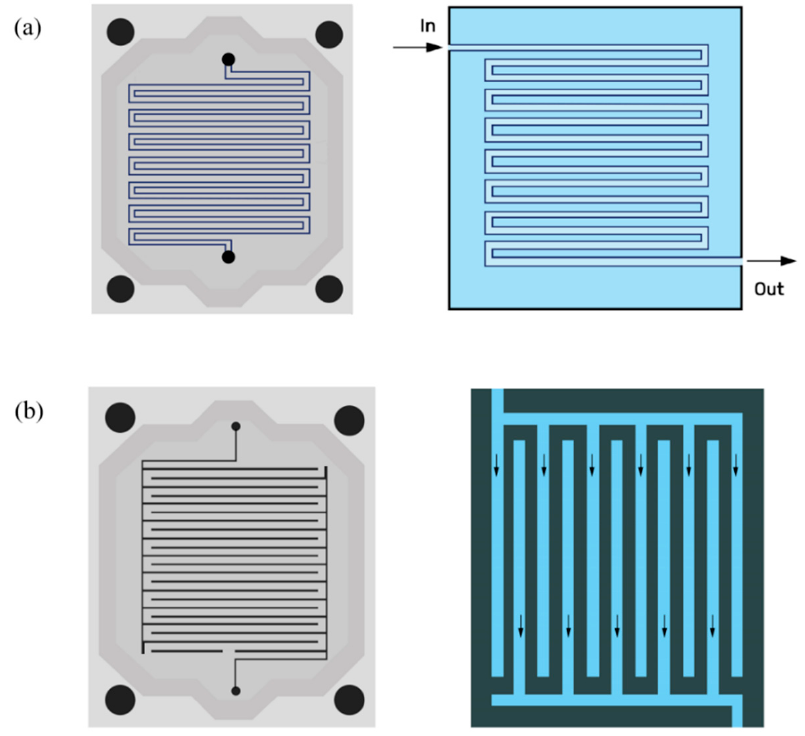
Figure 7. Flow channel designs: ( a ) Serpentine flow field; ( b ) Interdigitated flow field configuration. Redrawn from [20].